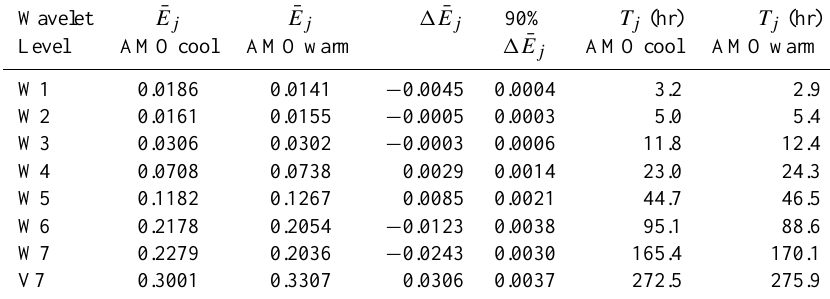
Table 4. NTR event energy and temporal periods at